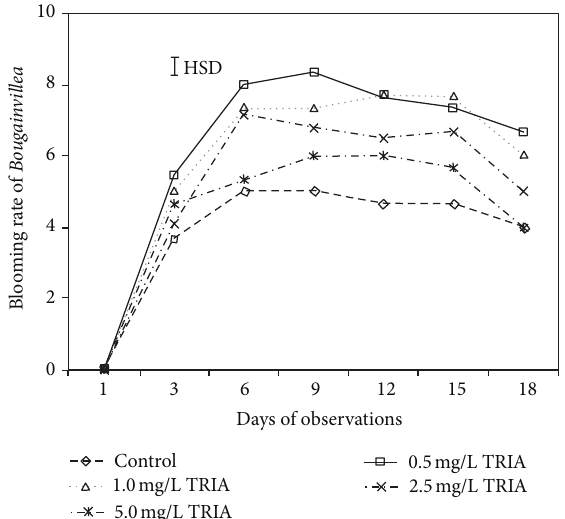
Figure 3: The effect of TRIA treatments on shoot length of Bougainvillea glabra under natural